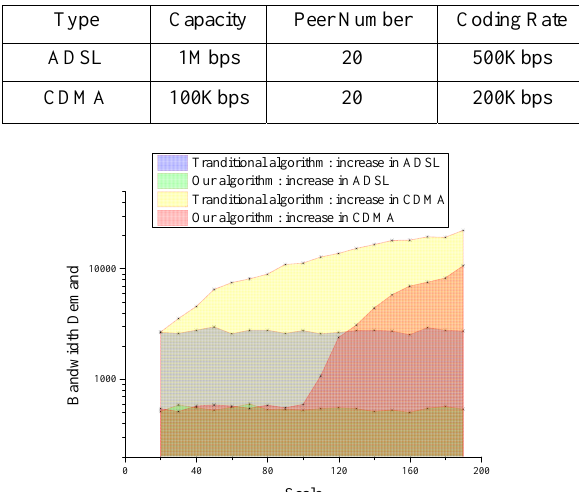
Table 1. Initial setting of HPSST